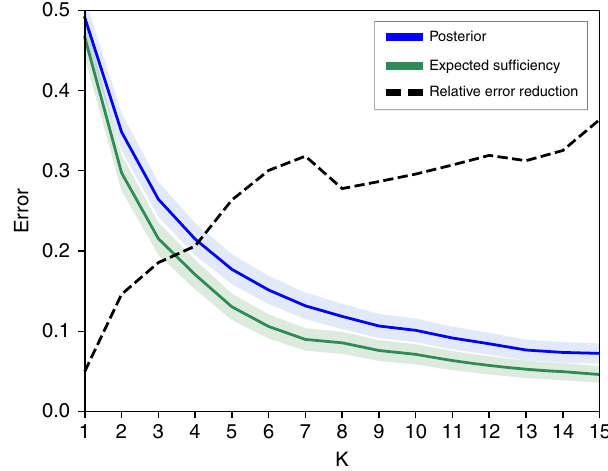
Fig. 3 Top k accuracy of Bayesian and counterfactual algorithms. Figure shows the top k error (1 — accuracy) of the counterfactual (green line) and associative (blue line) algorithms over all 1671 vignettes vs k . Shaded regions give 95% con fi dence intervals. The black dashed line shows the relative reduction in error when switching from the associative to counterfactual algorithm, given by 1 − e c / e a where e a is the error rate of the associative algorithm, and e c is the error rate of the counterfactual algorithm. Results shown for k = 1, … 15, for complete results see the supplementary table